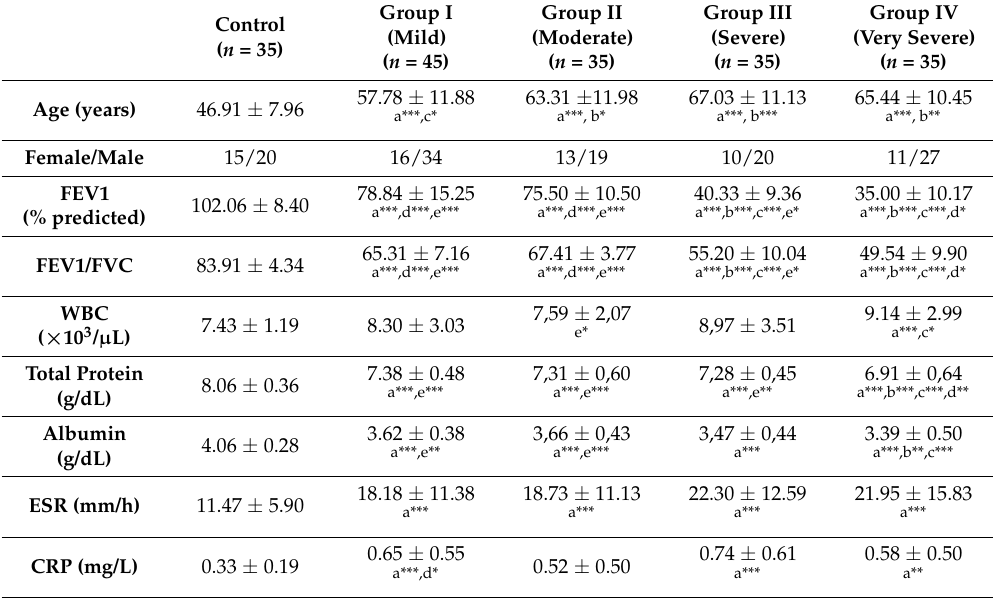
Table 1. Demographic, clinical, and laboratory findings of all